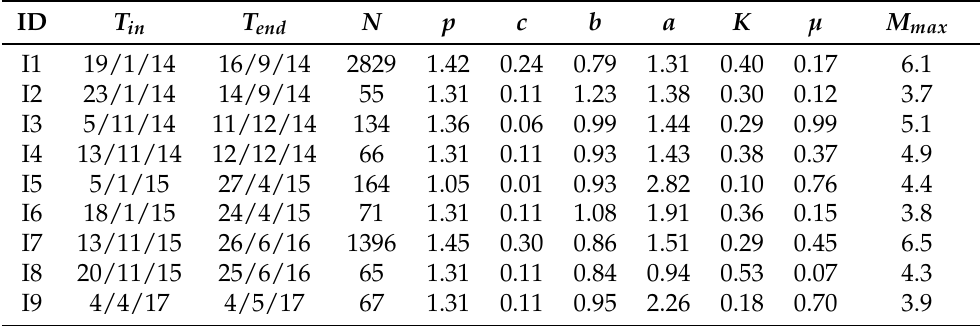
Table 7. Details on the 9 clusters with N ≥ 30 events in CII area and the inverted ETAS parameters. The generic values of the Omori law, p and c , are adopted for clusters with N <